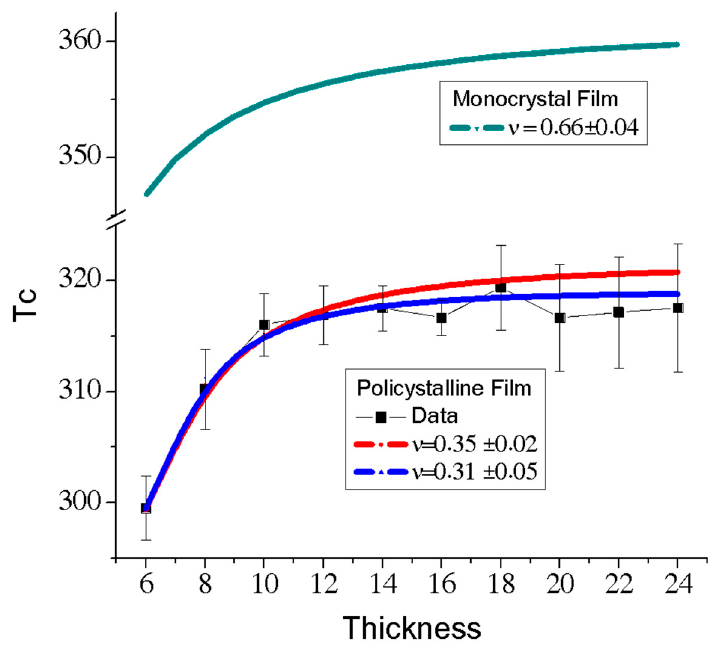
Figure 7. Dependence of the critical temperature on the thickness for polycrystalline films. The results were obtained with a low external field providing 0.1 meV of energy. The results of a fitting for the monocrystal film was added for comparison purposes. Fittings with four and five points are presented in red and blue, respectively.